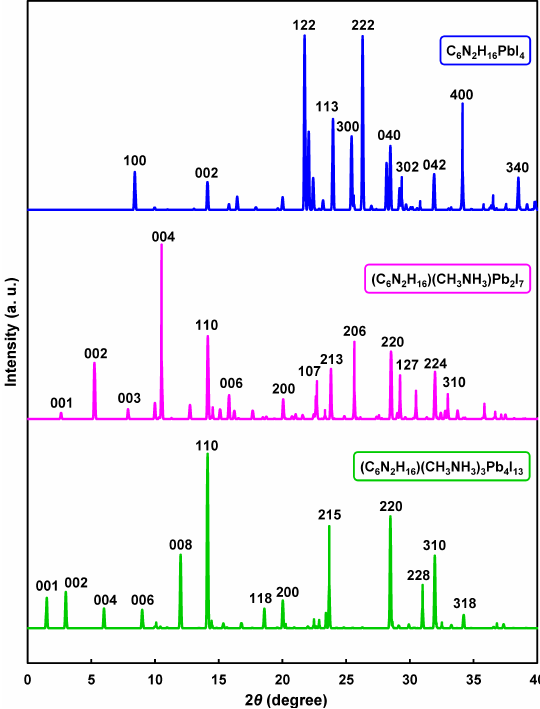
Figure 36: Calculated X-ray diffraction patterns of C 6 N 2 H 16 PbI 4 , (C 6 N 2 H 16 )(CH 3 NH 3 )Pb 2 I 7 , and (C 6 N 2 H 16 )(CH 3 NH 3 ) 3 Pb 4 I 13 with 2-dimensional perovskite